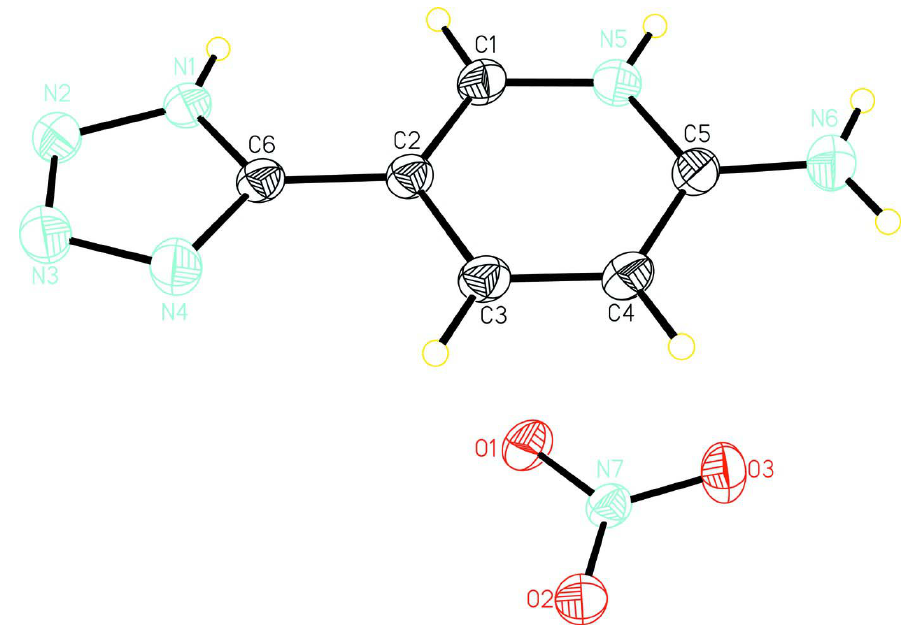
Figure 1 A view of the title compound with the atomic numbering scheme. Displacement ellipsoids were drawn at the 30% probability level.